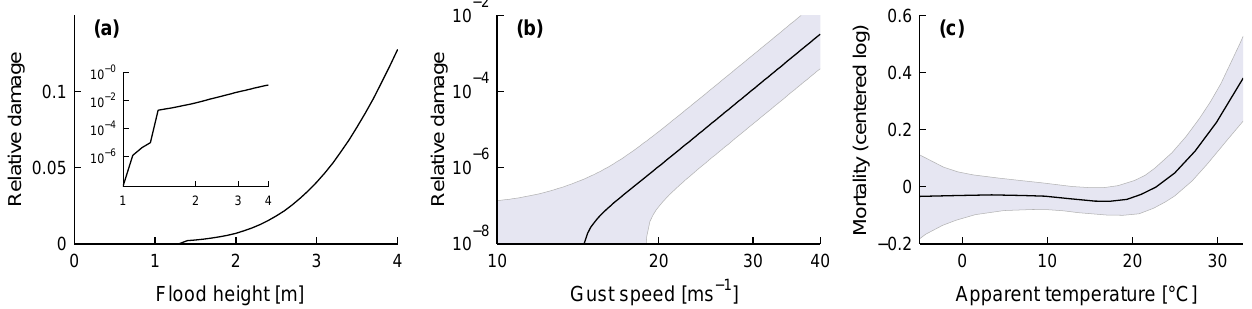
Figure 1. (a) Relative flood damage function obtained for the case study of Kalundborg (Boettle et al., 2011), with a log–log inset. (b) Relative storm-damage function for a German district (Prahl et al., 2012). (c) Damage function for the city of Bologna, relating mortality increase to apparent temperatures (data extracted from Stafoggia et al., 2006). The shaded areas in (b) and (c) represent uncertainty